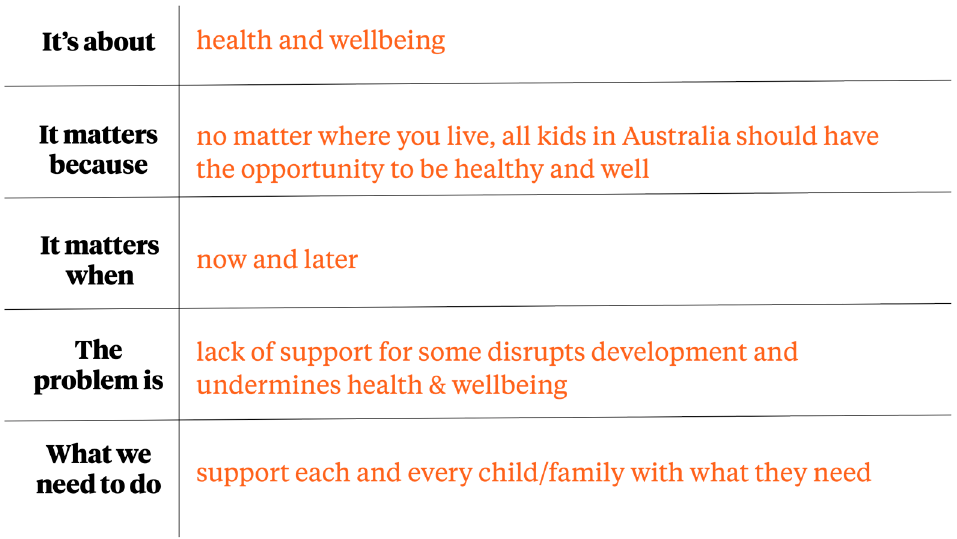
Figure 1. A new narrative strategy for the early childhood sector in Australia.